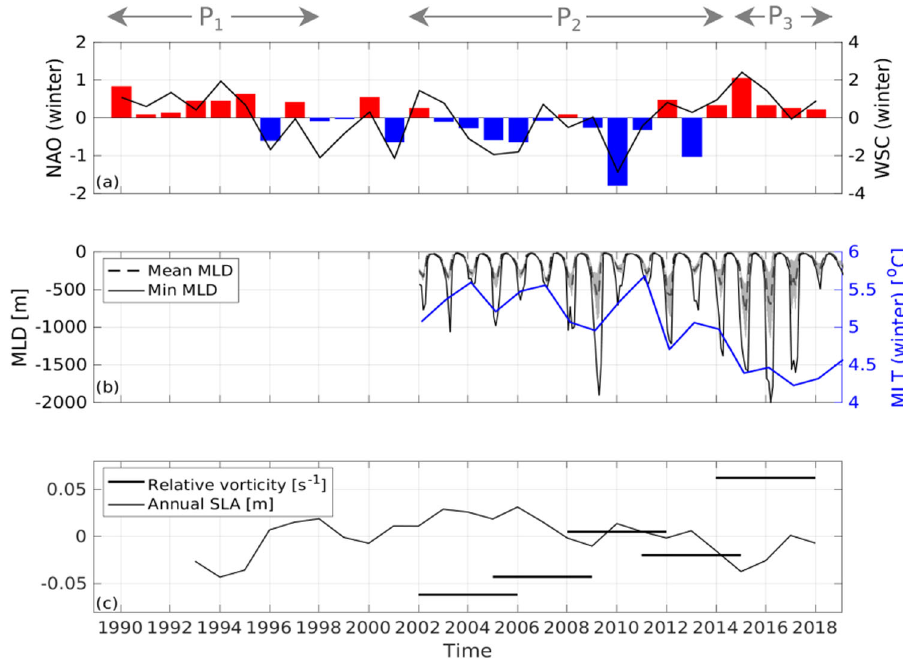
Fig. 5 Temporal variability of the North Atlantic subpolar gyre properties. a Winter North Atlantic Oscillation (NAO) index anomalies from 1990 to 2018, and winter Wind Stress Curl (WSC; N m − 2 ) from 1990 to 2018 (black curve) in the Irminger Sea. b Monthly Mixed Layer Depth (MLD; black curve) and Mixed Layer Temperature (MLT; ∘ C, blue curve) averaged in the Irminger Sea region from 2002 to 2018 computed from ISAS. The uncertainty in the mean MLD is computed as one standard deviation around the mean value. c The black curve represents the annual Sea Level Anomalies (SLA), detrended and offset by its mean (2.7 cm). The horizontal lines show the anomaly of the relative vorticity at 1000 m and average over 4-years periods. The three periods (P 1 , P 2 , and P 3 ) discussed throughout the manuscript are indicated with arrows on top of the fi